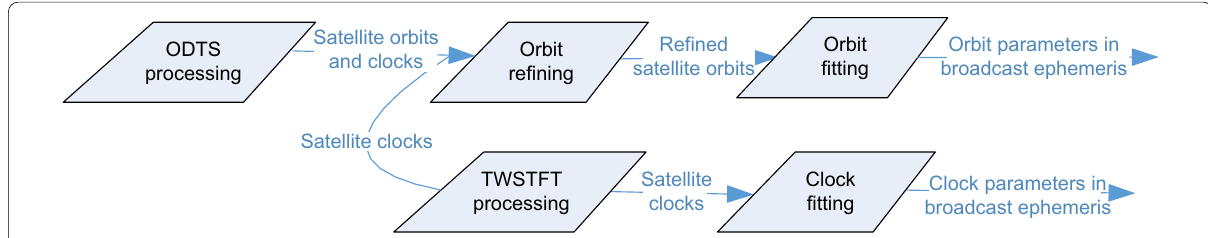
Fig. 4 Processing procedure of BDS broadcast orbits and clocks using refined